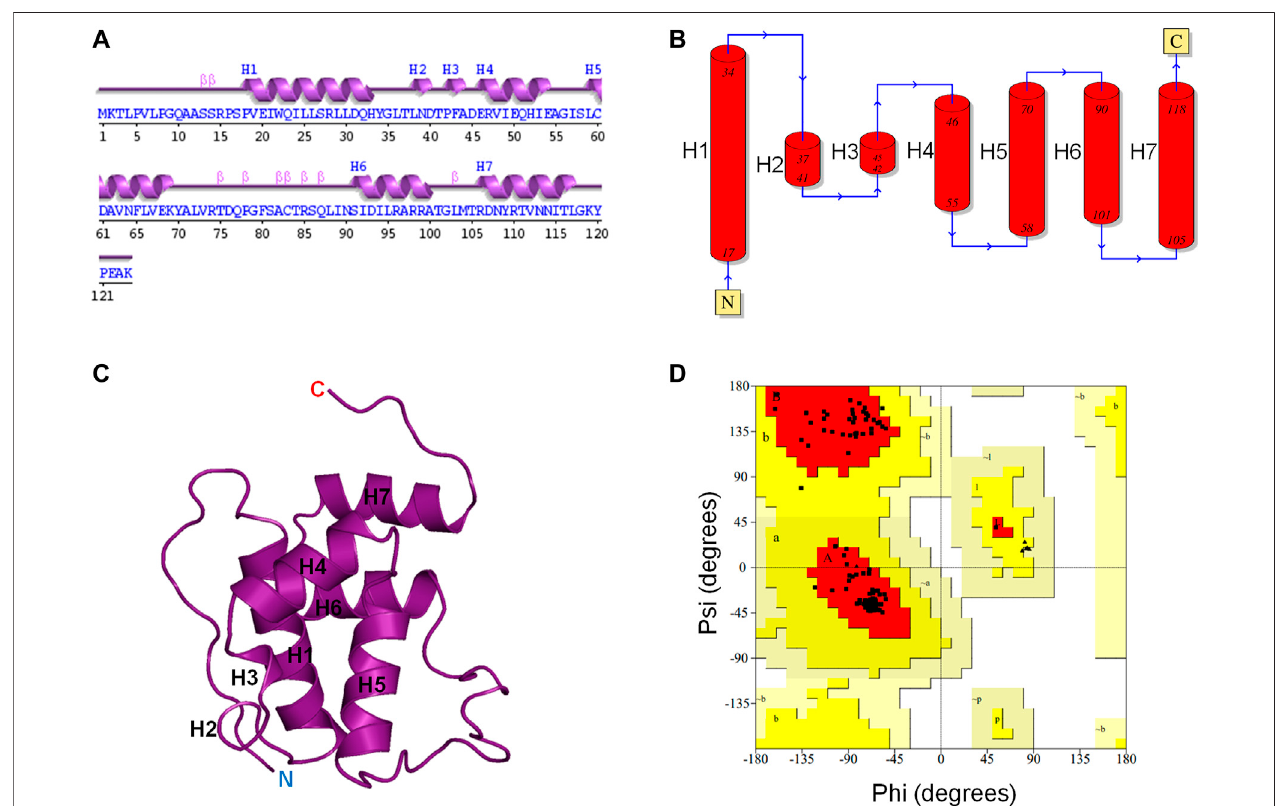
FIGURE 1 | CbtA modeling data. (A, B) Assigned secondary structures to the amino acid residues of the CbtA model. The Arabic numerals represent the amino acidsequencenumbers.H1,H4,H5,H6,andH7are α -helices.H2andH3are3 10 -helices. (C) ThePredicted3DfoldofCbtA. (D) ARamachandranplotshowingthePhi ( φ ) and Psi ( ψ ) combinations of the amino acid residues in